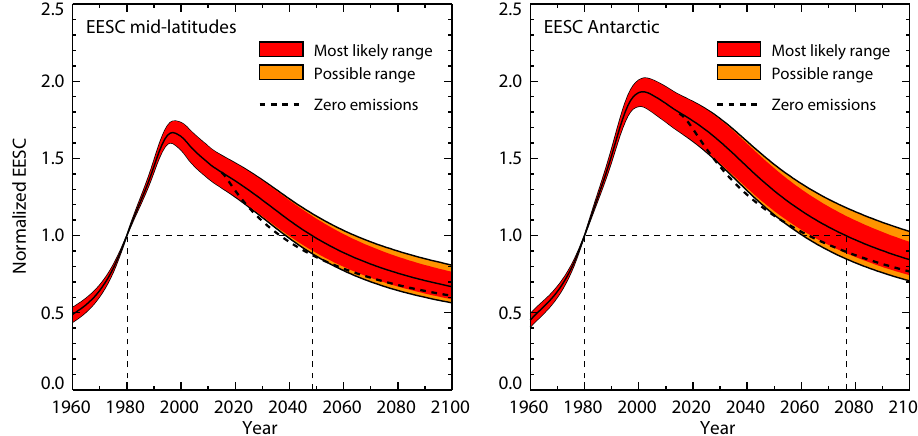
Fig. 6. Normalized EESC (1980 value set to 1) from 1960 to 2100 for midlatitude (left) and Antarctic (right) conditions using the lifetimes from SPARC (2013) and with uncertainties applied to all parameters. Shown are the median values and 95% confidence interval based on the possible (orange) and most likely (red) uncertainty ranges in lifetimes. The years EESC returns to pre-1980 levels for the median EESC values is indicated with thin dashed lines. The EESC curves corresponding to the zero-emission scenario are shown for reference.